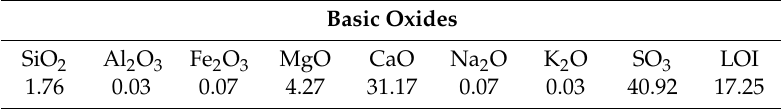
Table 4. Chemical composition of two-water gypsum,